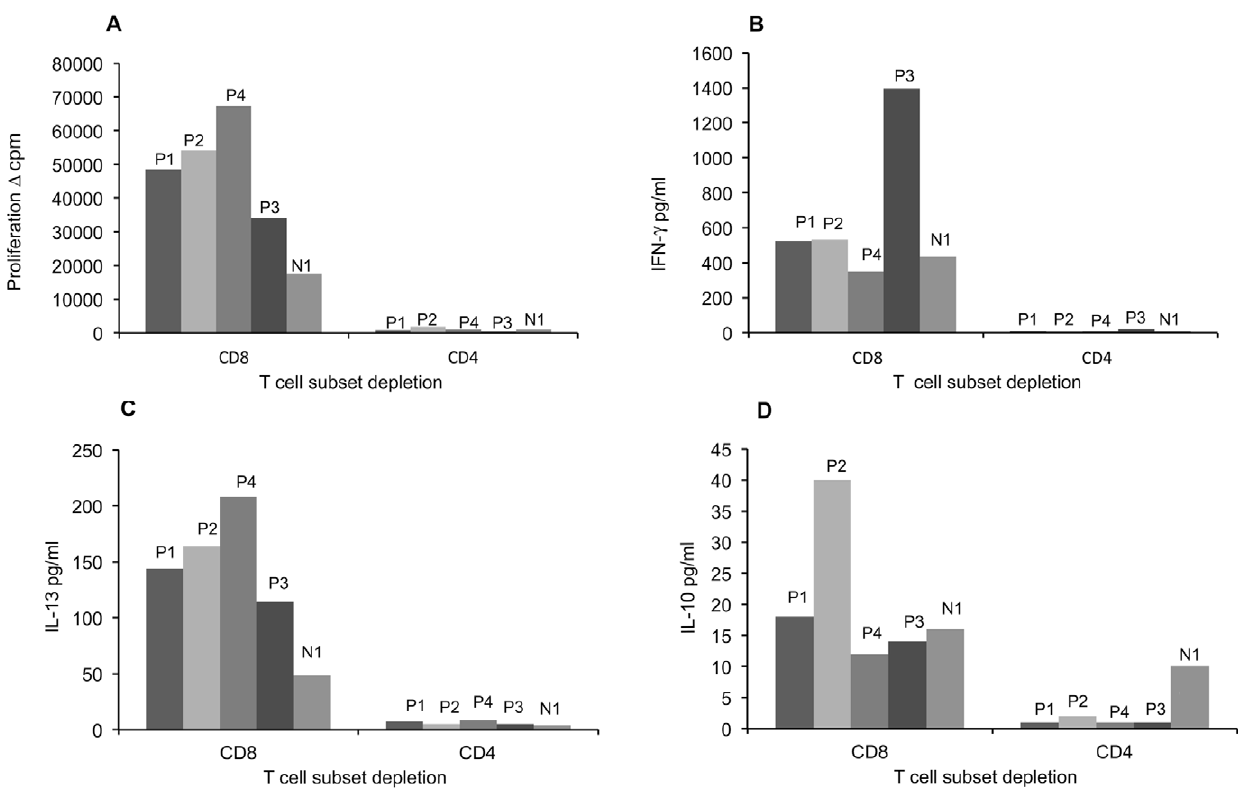
Figure 1. MCPyV VP1–specific T cell responses of MCPyV seropositive individuals after T cell subset depletion. PBMC of four MCPyV seropositive (P1 to P4) and one seronegative subject with strong MCPyV-specific CMI (N1) were depleted of either CD4 + or CD8 + T cells and stimulated with MCPyV VP1-VLPs (2.5 m g/ml). Proliferation (panel A) and cytokine (IFN- c , IL-13 and IL-10) responses (panel B, C, D) were studied by thymidine incorporation and ELISA,